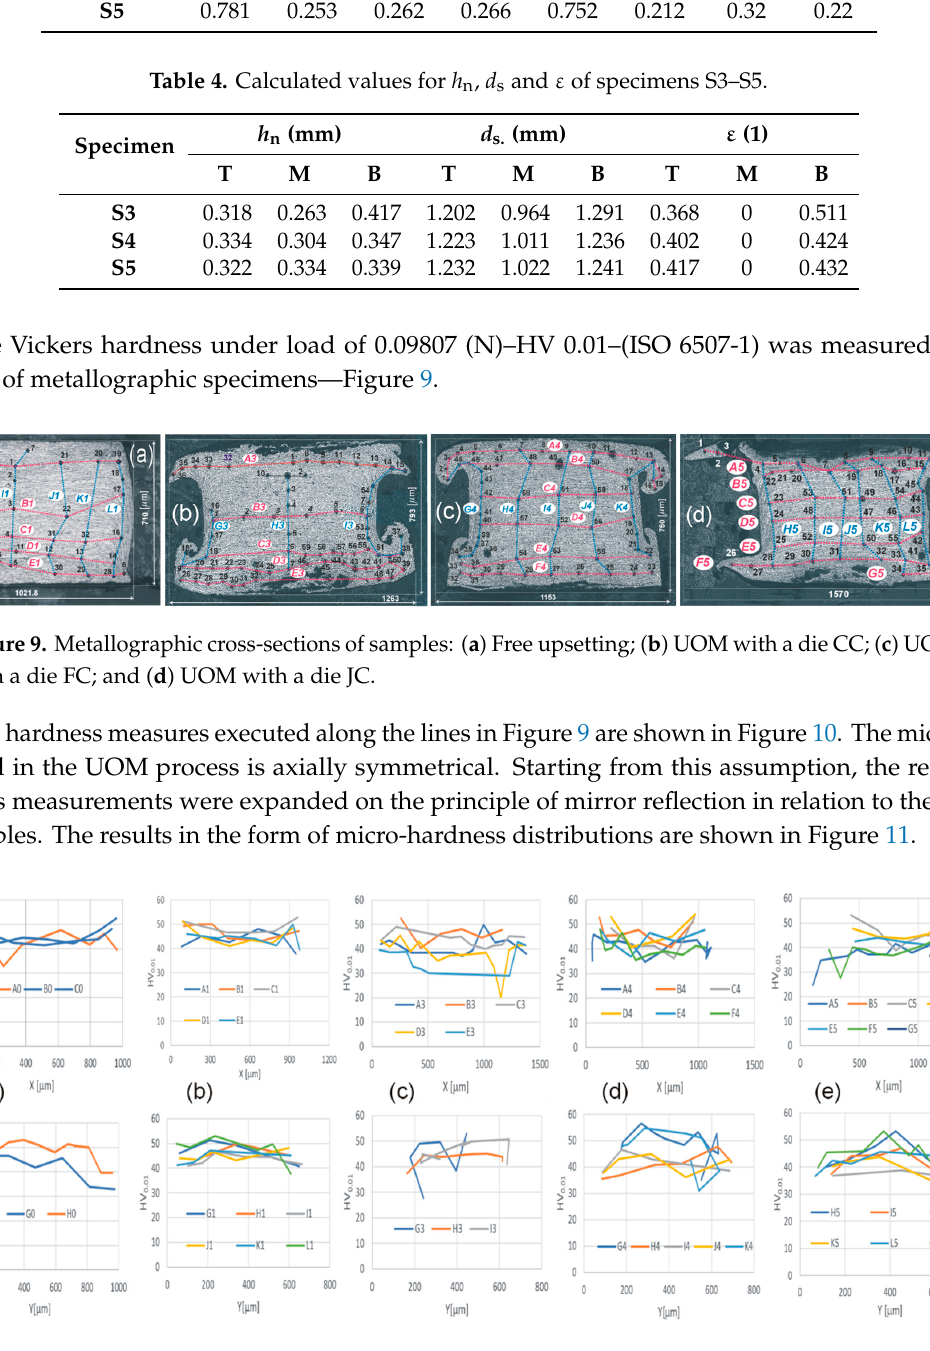
Figure 10. The results of micro-hardness measurements at the points marked in Figure 9 and in accordance with the courses of marked lines: ( a ) S0; ( b ) S1; ( c ) S3; ( d ) S4; ( e ) S5.